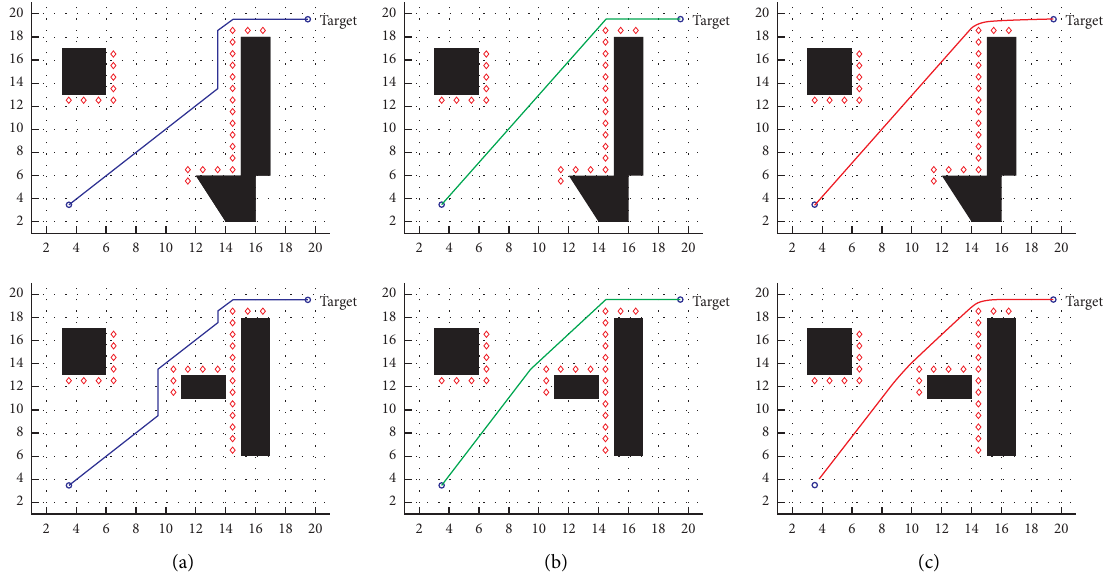
Figure 19: Path optimization based on the A ∗ algorithm. (a) Before optimization. (b) Greedy strategy optimization. (c) Bezier optimization.